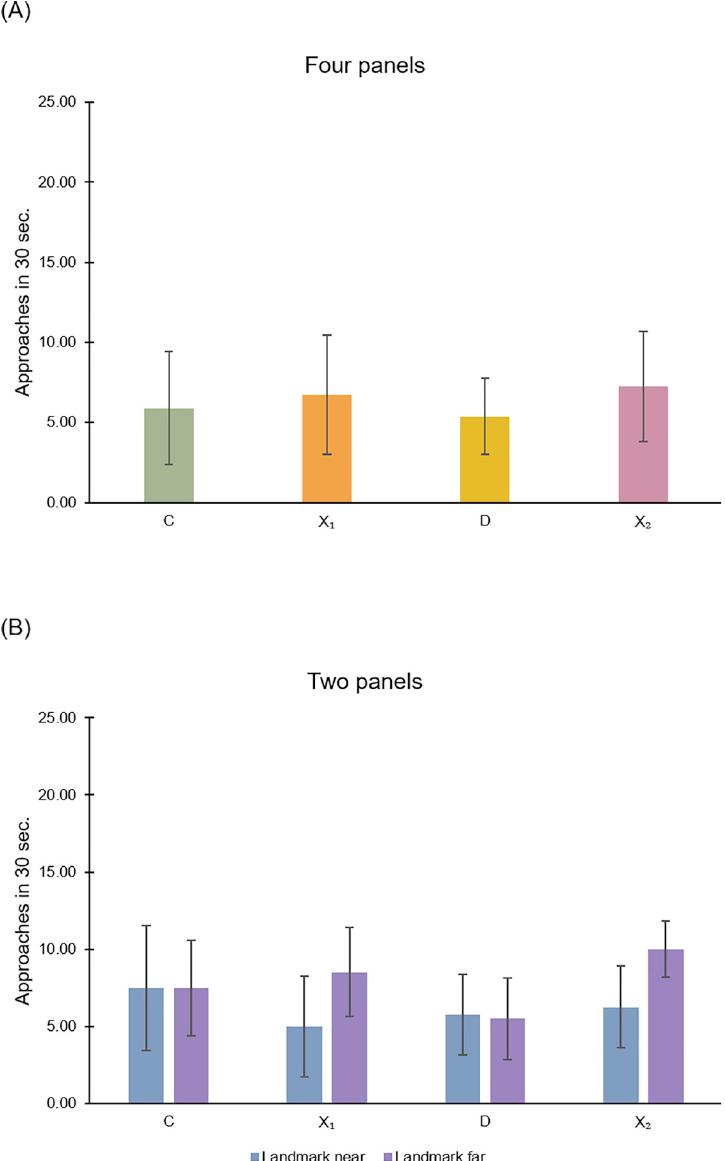
Fig 7. Total approaches in Experiment 2: Square apparatus with panels in the spontaneous memory task. (A): Mean (SD) number of approaches at the four corners in 30 seconds of test, in the spontaneous cued memory task, in the experimental condition with four colored panels at corners. (B): Mean (SD) number of approaches in 30 seconds of test in the experimental conditions with two colored panels at corners C-D (landmark near the correct corner) and X1-X2 (landmark far the correct